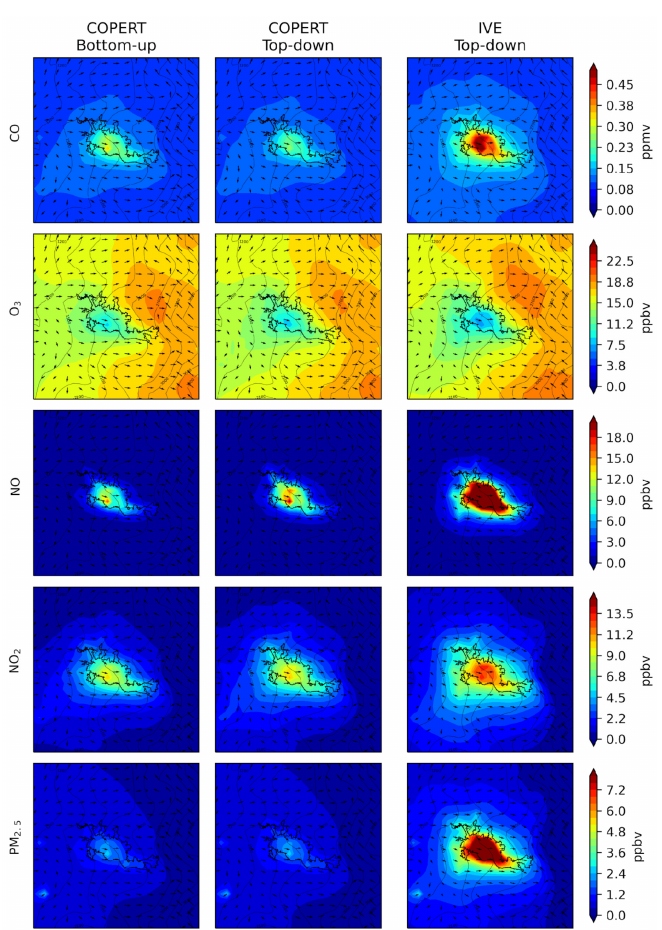
Figure 5. Average concentration of CO, O 3 , NO, NO 2 , and PM 2.5 for the period of